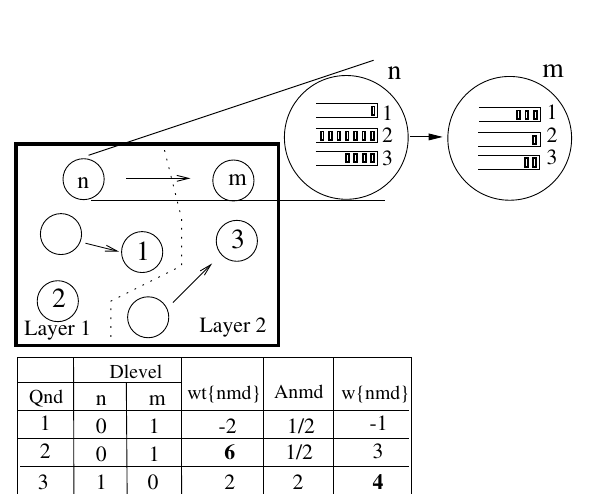
layer backpressure policy will prevent the packet from returning to node n